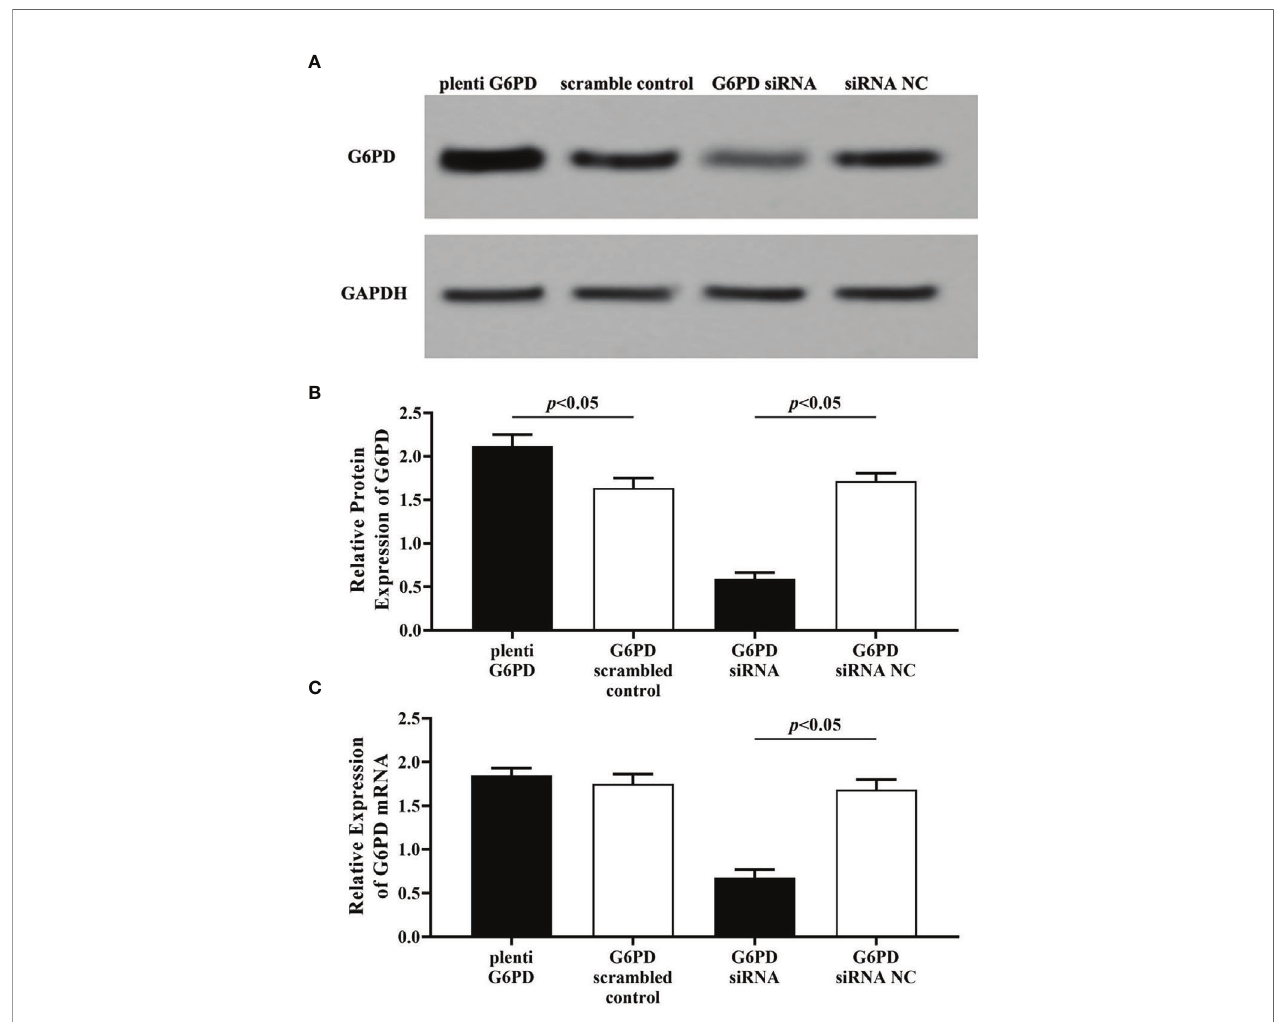
FIGURE 4 | Evaluation the transfection ef fi ciency of plenti G6PD and G6PD siRNA. The expression levels of G6PD protein (A, B) and G6PD mRNA (C) were indicated by Western blots or RT-qPCR. (A) Representative blots from four groups. Statistical plots of the relative expression of G6PD protein (B) and G6PD mRNA (C) . Data are presented as means ± SD (n =